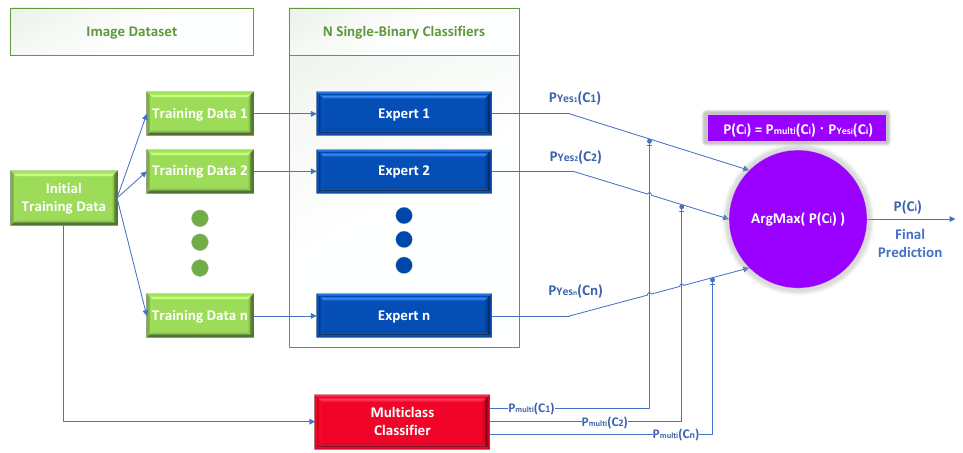
Figure 4. Mixture of experts; one-vs.-rest